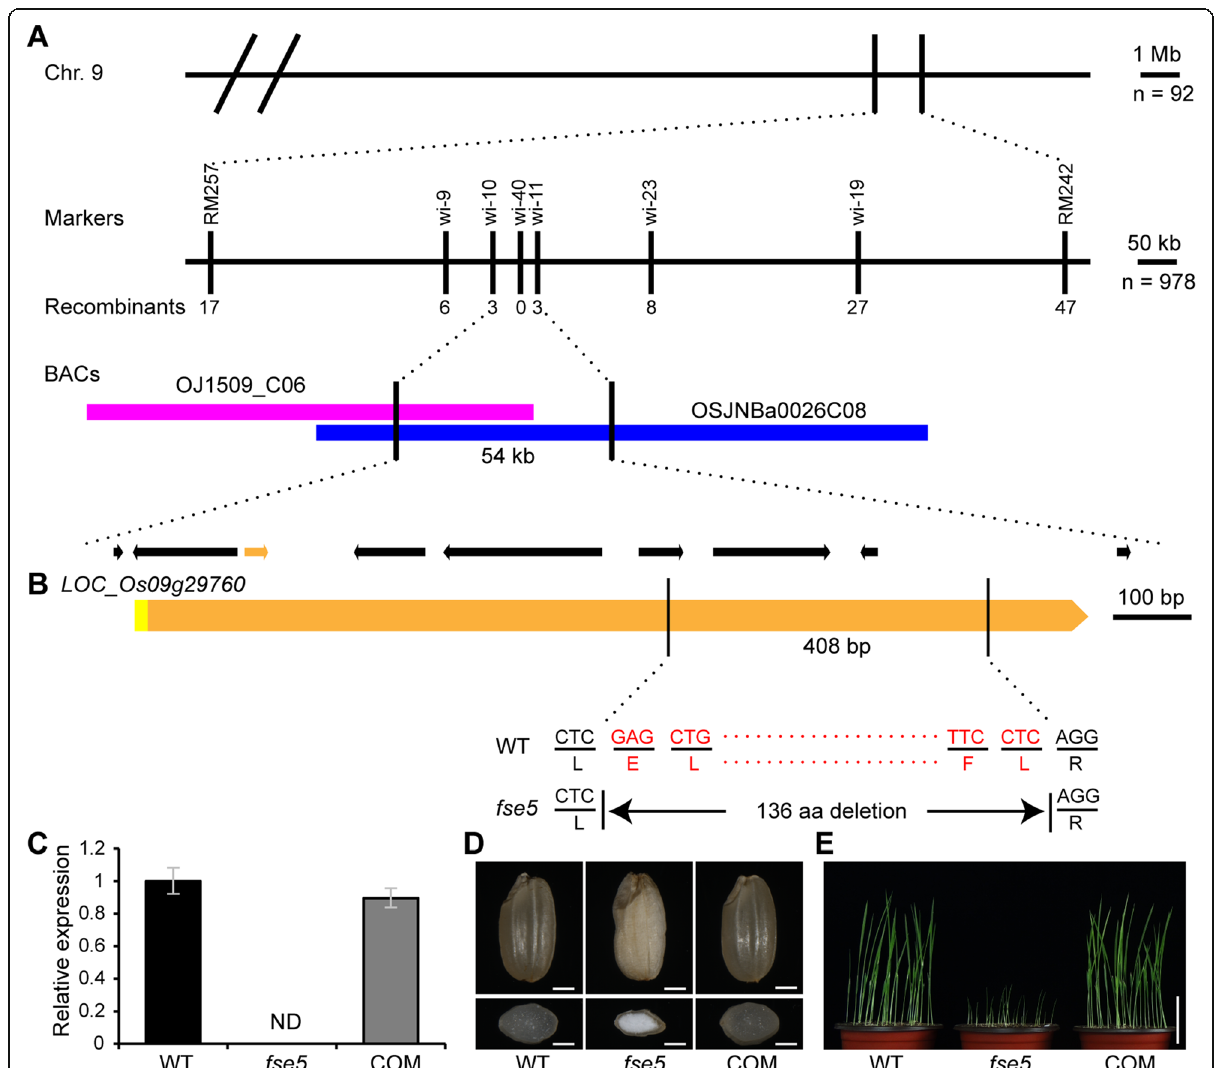
Fig. 3 Positional cloning of the Fse5 locus. a The Fse5 locus was restricted to a 54 kb region flanked by markers wi-10 and wi-11 on chromosome 9 (Chr. 9) and included nine ORFs. Both markers and numbers of recombinants are shown. b Mutation site in LOC_Os09g29760 in the fse5 mutant. A deleted 408 bp fragment near the end of the exon leads to a 136 aa truncation in the putative encoded protein in the fse5 mutant. The red letters and dotted lines represent the deletion in LOC_Os09g29760 or its encoded protein in the fse5 mutant. The yellow and orange boxes indicate the 5 ′ untranslated region (UTR) and single exon of LOC_Os09g29760 , respectively. c Expression of LOC_Os09g29760 in WT, fse5 mutant and complemented (COM) lines. The primer pair designed within the 408 bp deletion was used in qRT-PCR. Three biological replicates were subjected to qRT-PCR. OsActin1 was used as an internal control for data normalization. The values are the means ± SDs. ND, not detected. d Phenotypes of seeds (upper panel) and transverse sections (lower panel) of WT, fse5 mutant and COM seeds. Bars, 1 mm. e Nine-day-old seedlings of WT, fse5 mutant and COM lines. Bar, 5